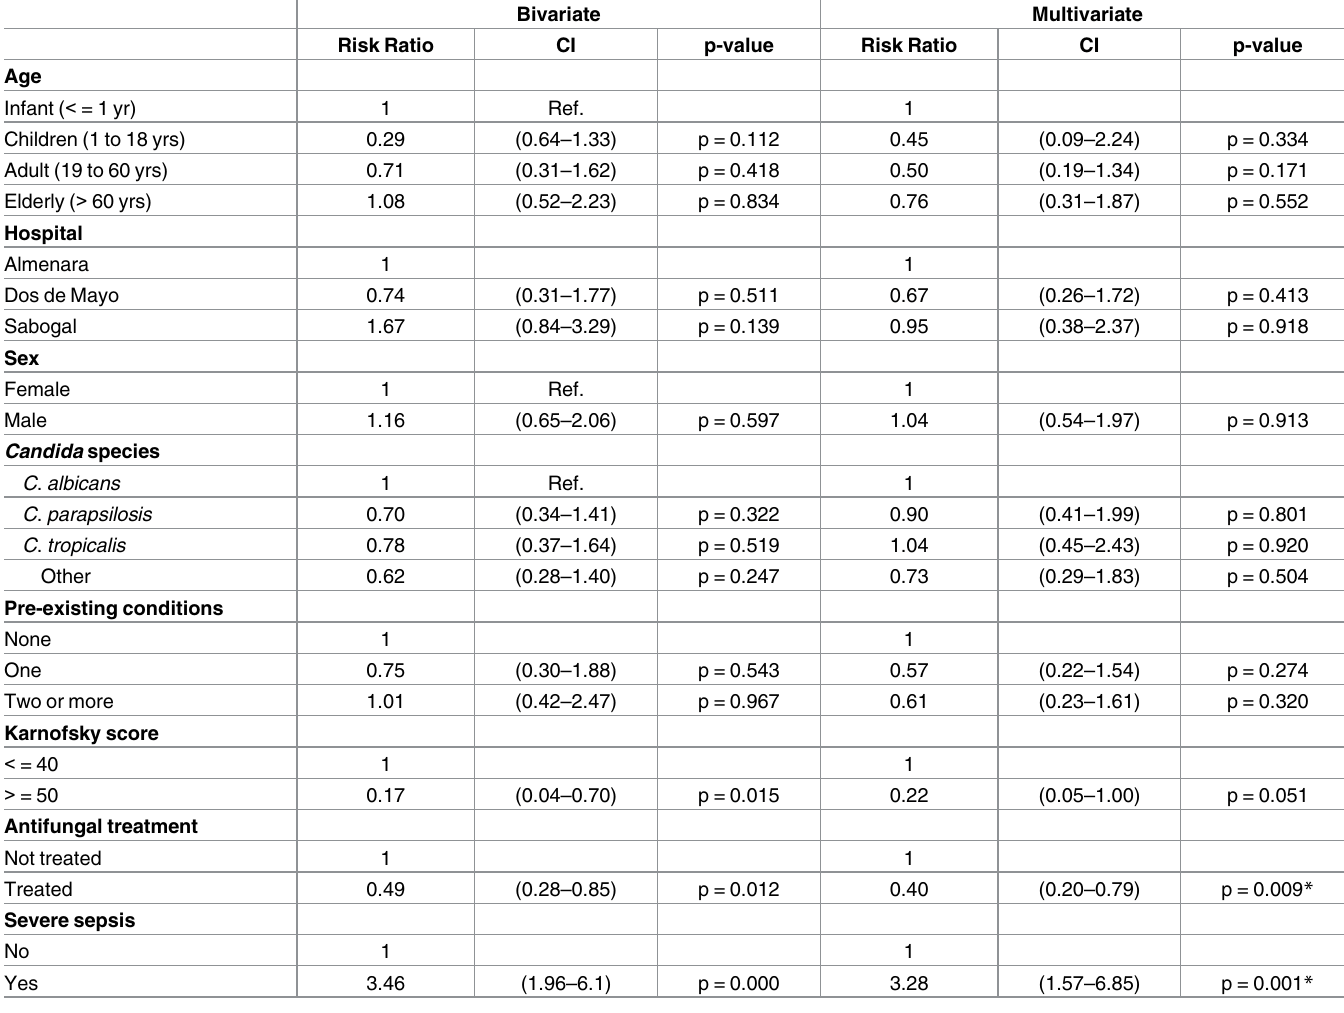
Table 4. Univariate and multivariate mortality